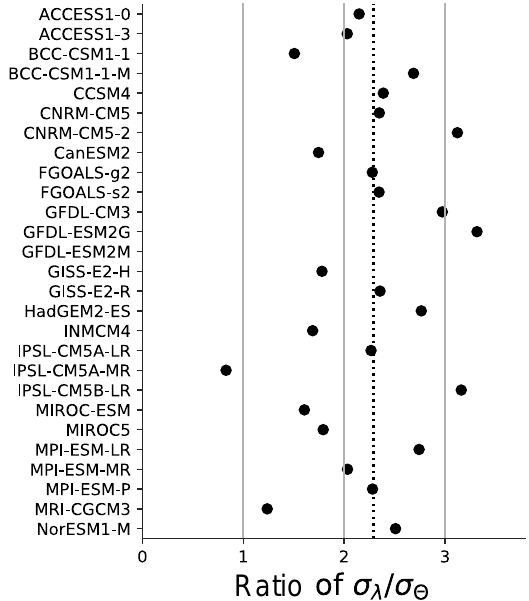
Figure 7. The standard deviation (SD) of the λ time series divided by the SD of the (cid:50) time series. Each time series is calculated from 17-year segments of CMIP5 control runs. The dotted line is the en- semble average.